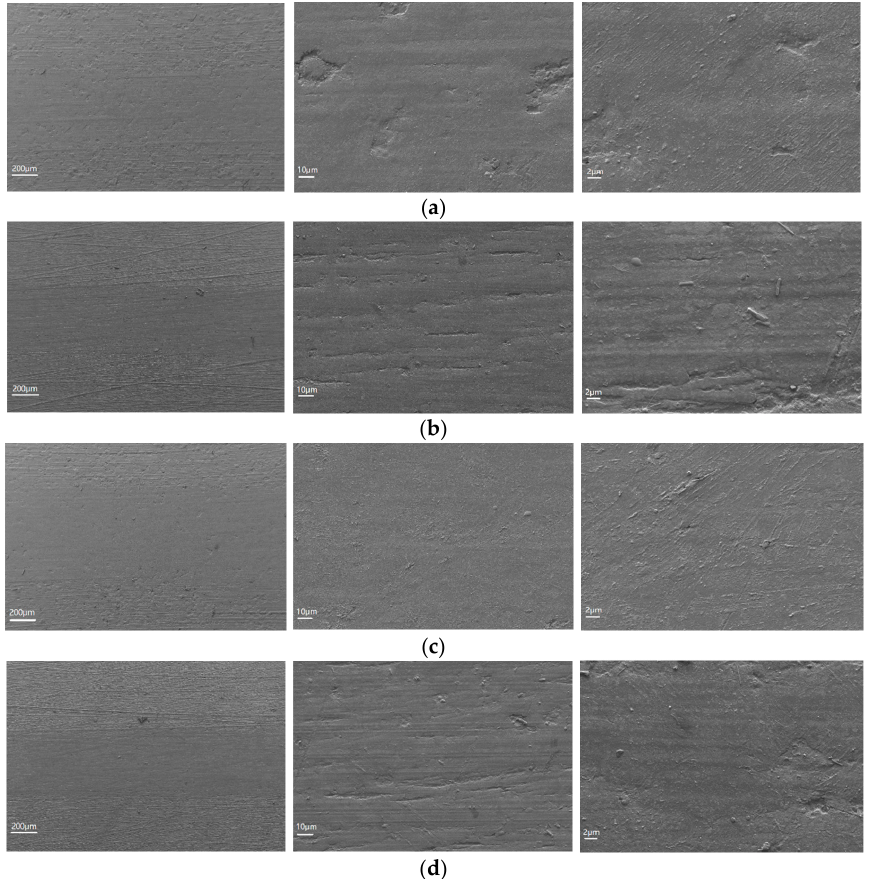
Figure 5. SEM micrographs of worn surfaces PEEK/PTFE composites: ( a ) PEEK/PTFE; ( b ) PEEK/PTFE + 30% CFs; ( c ) PEEK/PTFE + 20% CFs + 10% Gr; ( d ) PEEK/PTFE + 10% CFs + 20% Gr.